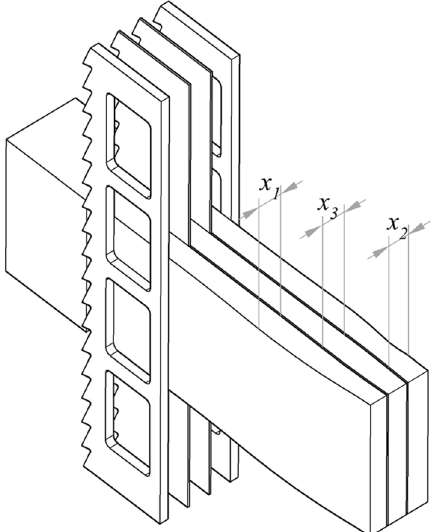
Figure 1. The set of saw blades in the gang with the obtained lamellae (drawing designed in AutoCad 2020 https:// www. autod esk. com/ produ cts/ autoc